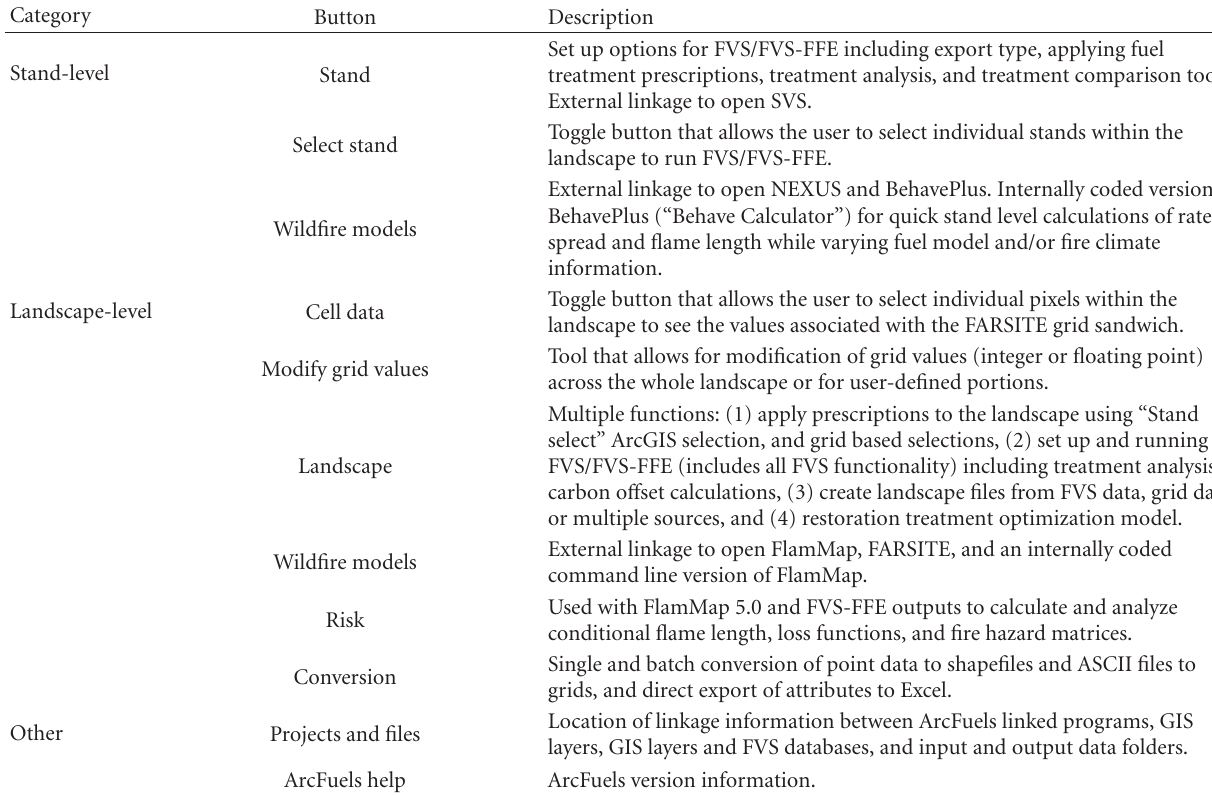
Table 3: ArcFuels toolbar button descriptions.